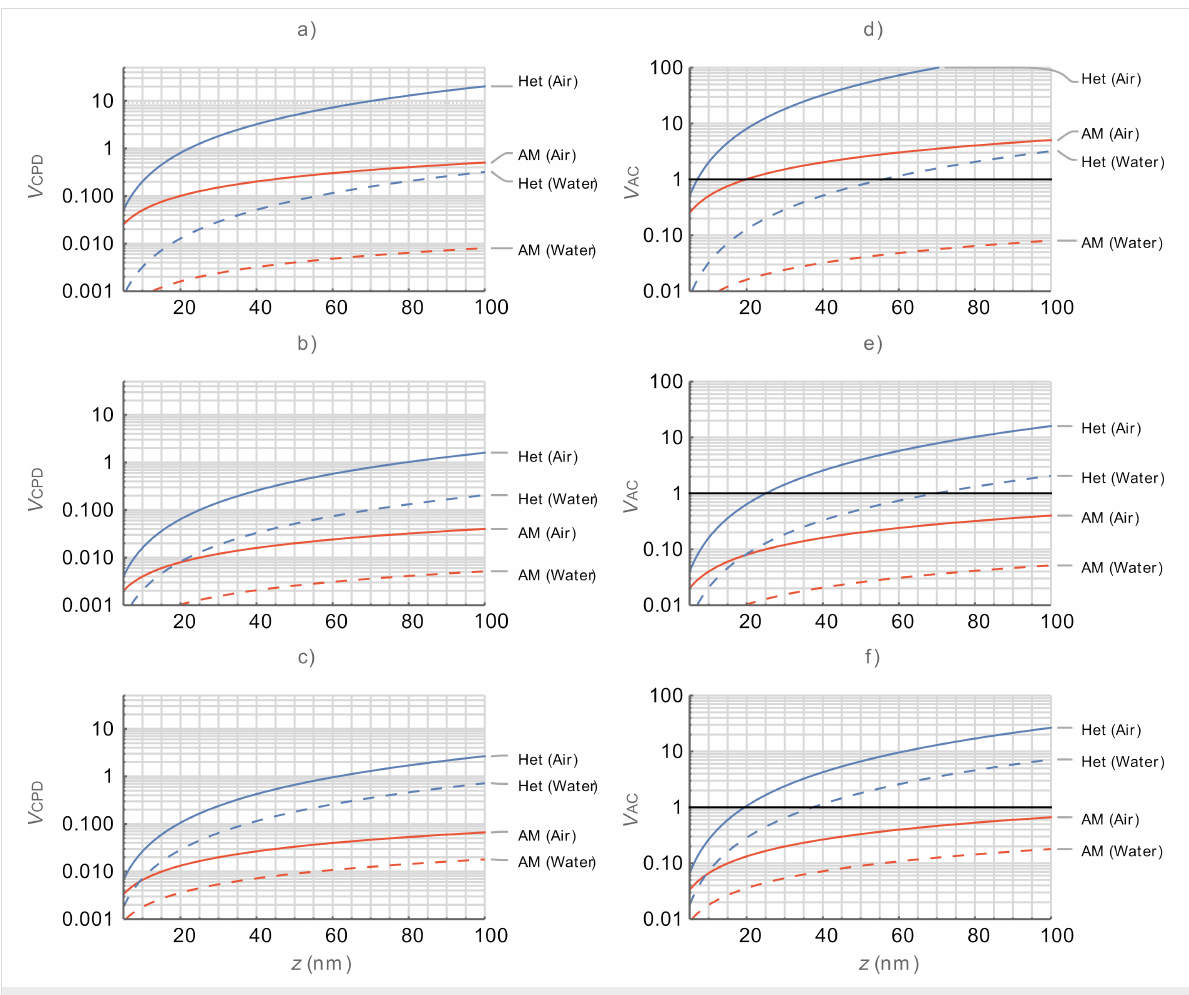
Figure 2: Performance characteristics of single-frequency detection techniques (AM and Het) as a function of the tip–sample separation, z . (a–c) and (d–f) for the first harmonic electrostatic response occurring ω off (top), ω 1 (middle), and ω 2 (bottom), respectively. AM (red) and Het (blue) for air (solid) and water (dashed). is calculated for V AC = 1.0 V. is calculated for V CPD = 0.1 V. The black lines in (d–f) indicate V AC = 1.0 V. Lower bias is better for all